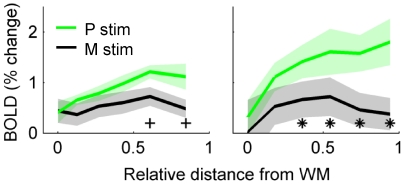
Visual responses to parvocellular-targeted stimuli are maximally differentiated from magnocellular-targeted stimuli in superficial gray matter.Full-field visual stimuli were targeted at the parvocellular pathway (P stim: 2 Hz contrast-reversing circular gratings composed of 1 cycle per degree iso-luminant red and green checks) and the magnocellular pathway (M stim: 15 Hz contrast-reversing gratings with 0.3 cycles per degree sinusoidal luminance modulation). Green lines indicate estimated BOLD response to P stimuli (shading indicates standard error across 6 or 8 scans in each subject, respectively); black lines indicate estimated BOLD response to M stimuli. Asterisks indicate significance at a given cortical depth (p<0.05, paired t-test, corrected for 10 comparisons in the 5 depth bins, 2 subjects); daggers indicate p<0.1, corrected.